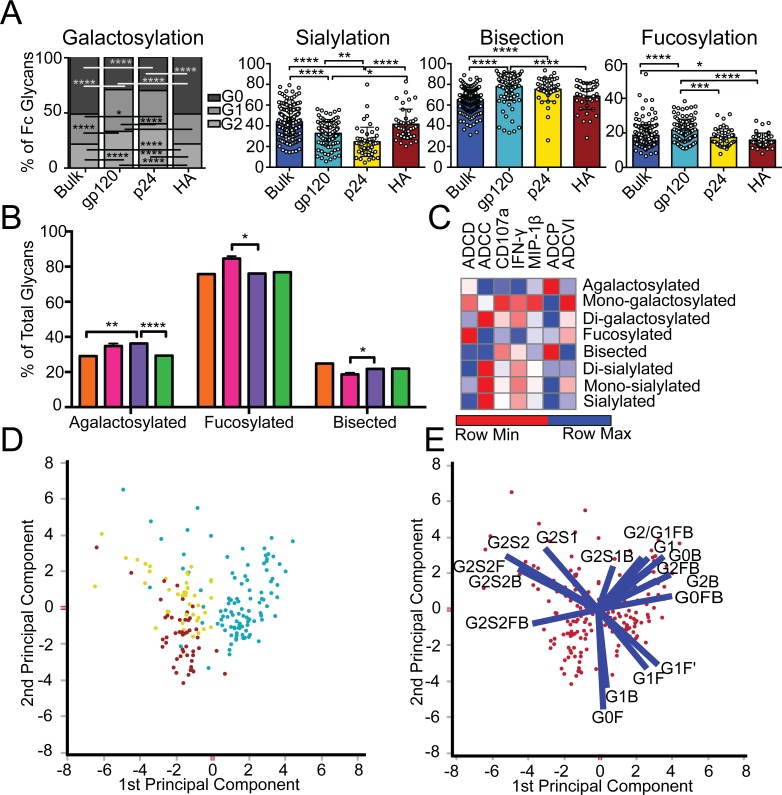
Antibody glycosylation is programmed in an antigen-specific manner.(A) Glycosylation was assessed on whole bulk-circulating and antigen-specific IgG antibodies directed against gp120 (n = 103), p24 (n = 47), and HA (n = 40) isolated from a cohort of 193 HIV-infected subjects. The dot plots represent the percent of glycan structures that contain galactose (G0 = agalactosylated, G1 = mono-galactosylated, G2 = di-galactosylated) or that contain sialic acid (S = sialylated), fucose (F = fucosylated), or a bisecting GlcNAc (B = bisected). Differences between groups were compared using Kruskal-Wallis test with Dunn’s multiple comparison’s test (*p<0.05, **p<0.01, ***p<0.001, ****p<0.0001). (B) Differences in glycosylation for gp120-specific antibodies from chronic treated (orange), chronic untreated (pink), viremic controller (purple) and elite controller (green) HIV patients were compared using two-way ANOVA with Tukey’s multiple comparison test (*p<0.05, **p<0.01, ***p<0.001, ****p<0.0001). (C) Antibody glycosylation levels on gp120-specific antibodies among chronic HIV-infected individuals were measured along with seven different gp120-specific effector functions. The correlations between gp120-specific antibody glycosylation and gp120-specific functional parameters were assessed using spearman correlations. Antibody dependent complement deposition (ADCD), antibody dependent cellular cytotoxicity (ADCC), antibody mediated NK cell activation (degranulation-CD107a, IFN-γ, or MIP-β secretion), antibody dependent cellular phagocytosis (ADCP), and antibody dependent cellular viral inhibition (ADCVI) are depicted. Significant correlations were identified for: Fucose—ADCC*, Di-sialylated—ADCC**, mono-galactosylated—ADCP*, Di-galactosylated—ADCP**, Bisection—ADCP* and Mono-sialylated—ADCP** (*p<0.05, **p<0.01, ***p<0.001, ****p<0.0001). (D), (E) To gain a multivariate sense of the overall glycan profile differences among antigen-specific antibodies, antigen-specific antibody glycan profiles (gp120- (teal), HA- (yellow) and p24- (red) specific antibodies) were compared using principle components analysis (PCA). Each dot on the score plot (D) represents an antigen-specific antibody glycan profile from a single individual and the loadings plot (E) shows the contribution of individual analyzed glycan structures to driving the separation between the antigen-specific antibody glycan profiles. Vector length represents the magnitude of individual glycan structure effects on overall separation in antibody glycan profiles, with longer vectors represent features that are further from the mean and that drive a larger effect on separating antibody glycan profiles. Moreover, location on the loadings plot is identical to location on the score plot, determined by the collective influence of all vectors. This analysis accounts for 42.9% of the glycosylation variation across the antigen-specific antibody specificities.